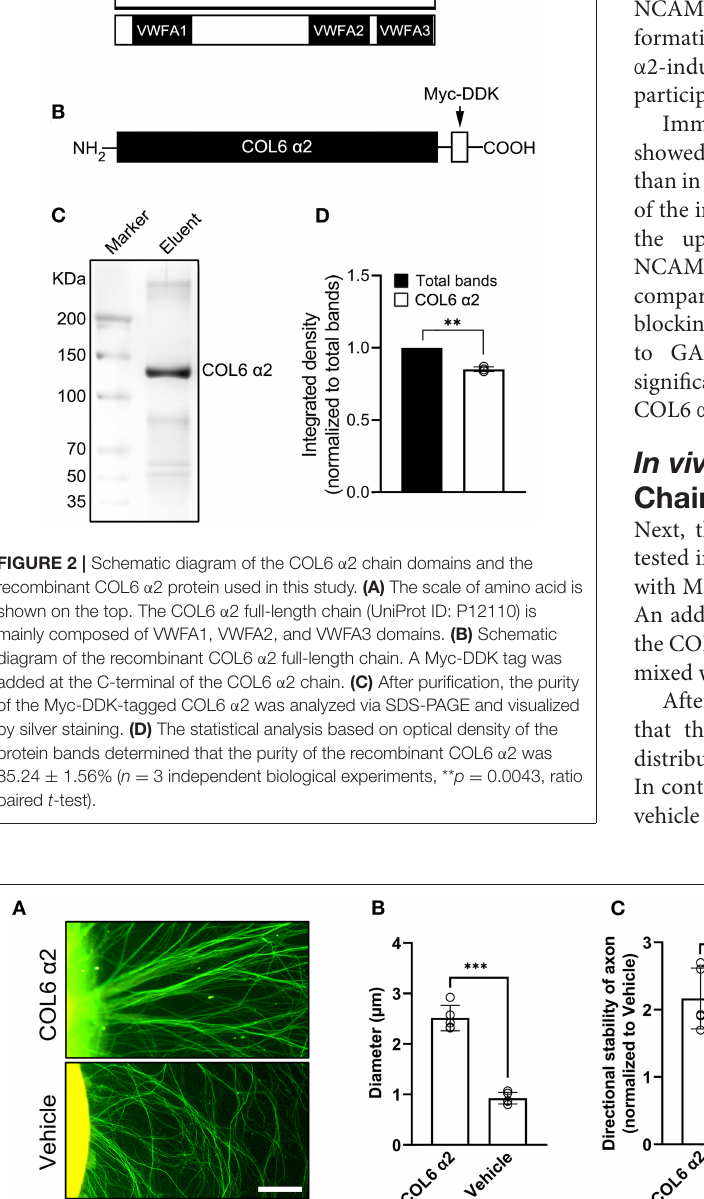
Frontiers in Cellular Neuroscience |